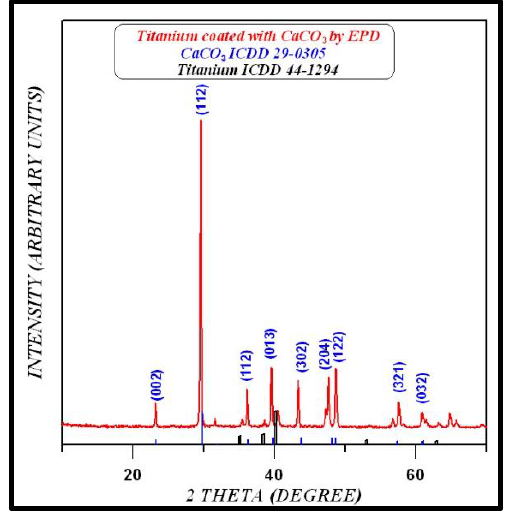
Figure 2: X-ray diffraction patterns of CaCO 3 coated CP Ti sample using EPD technique Clinical observation